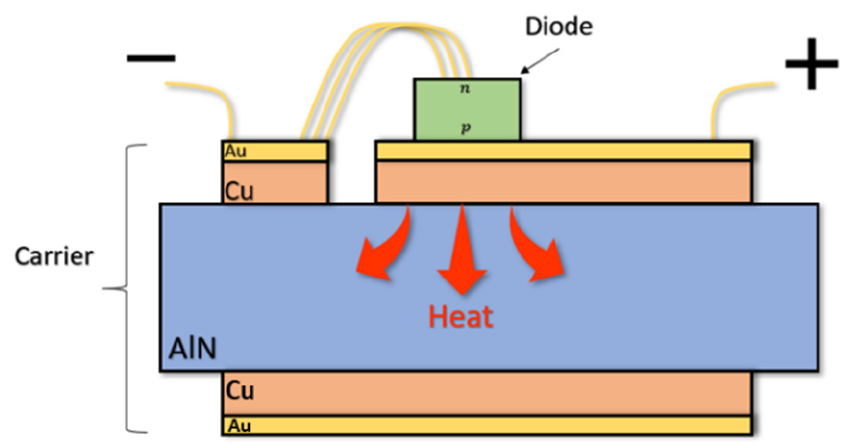
Figure 6. Effect of the thickness of Cu layers in the carrier: ( a ) refractive index component changes ( b ) DoP as a function of the Cu layer thickness and the intrinsic refractive index anisotropy.